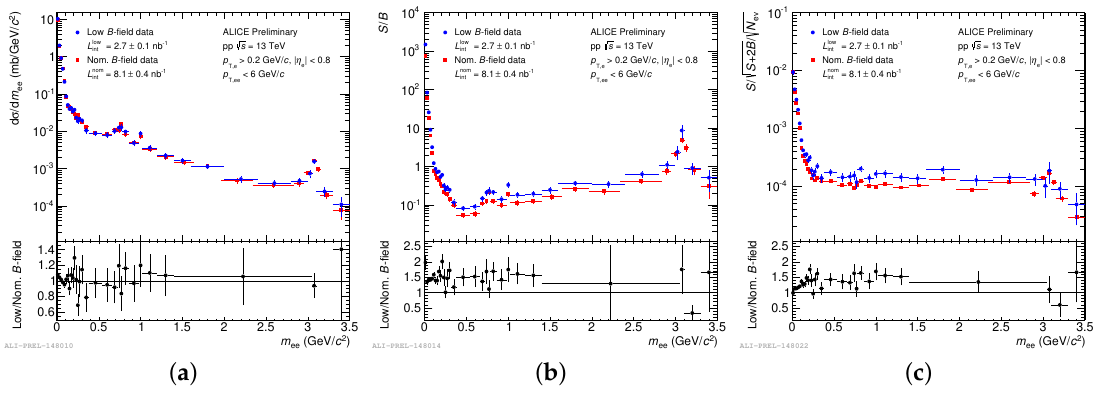
Figure 2. Comparison of: ( a ) the differential dielectron cross section d σ /d m ee ( b ) the signal-over-background ratio S / B ( c ) and the statistical significance per event as a function of m ee of the low-field analysis (red) to the nominal field analysis [3] (blue) both with a p T > 0.2 GeV/ c